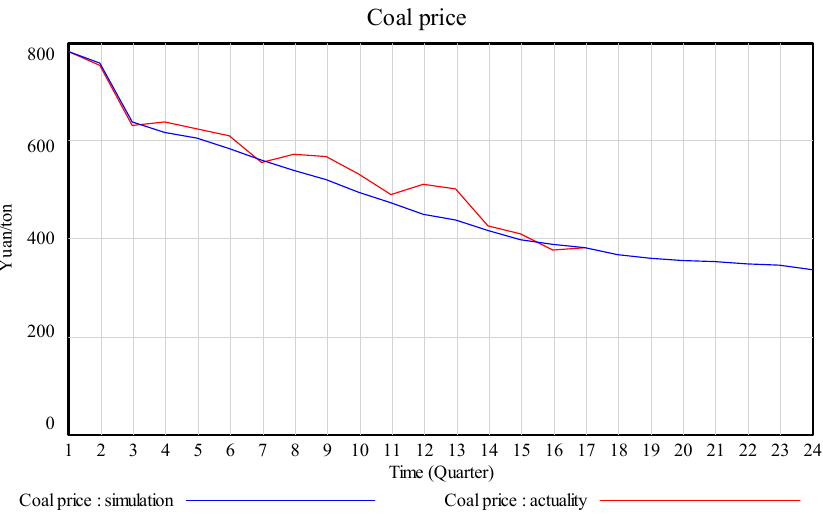
Figure 6. Comparison chart of simulated coal price and actual coal price.